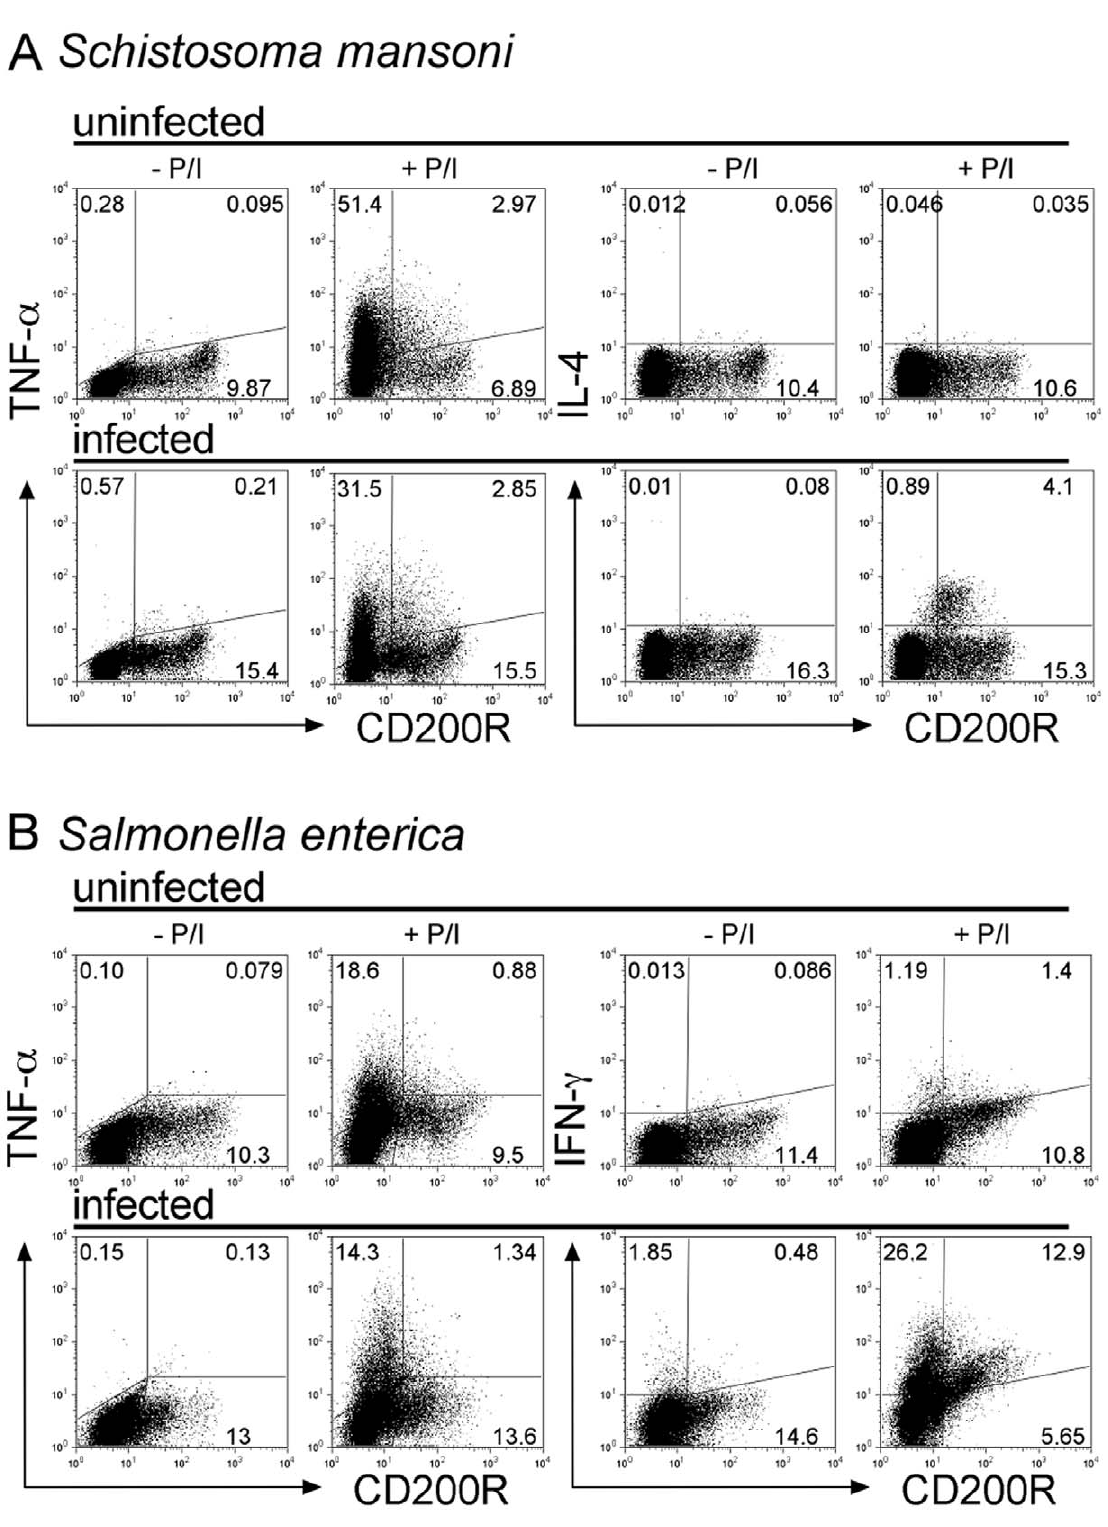
Figure 4. Effector cytokine potential is acquired alongside CD200R expression in vivo. Dot plots show cytokine + gated CD4 cells ex vivo (- P/I) and after recall with pdbU + Ionomycin ( + P/I, 5h); gates are based on unstimulated controls (-P/I). A. Infection with S. mansoni (8wk) increased CD200R + IL-4 + CD4 cells in MesLN from 0.017 6 0.019% to 3.39 6 1.36% and 83 6 4.14% of IL-4 + cells were CD200R + , while CD200R – TNF a + CD4 cells decreased from 47.5 6 4.66% to 30.0 6 0.99%. (n=3, p=0.01). B. Infection with S. enterica increased IFN c + CD4 cells in spleen from 1.9 6 0.65% to 31.1 6 4.4% and 49.5 6 9.86% of IFN c + cells were CD200R + , while CD200R – TNF a + CD4 cells decreased from 19.6 6 2.31% to 15.1 6 1.56%. (n=5, p=0.01). Results are representative of at least 3 (A, n=3 mice/group) and 2 (B, n=5 mice/group) independent experiments.